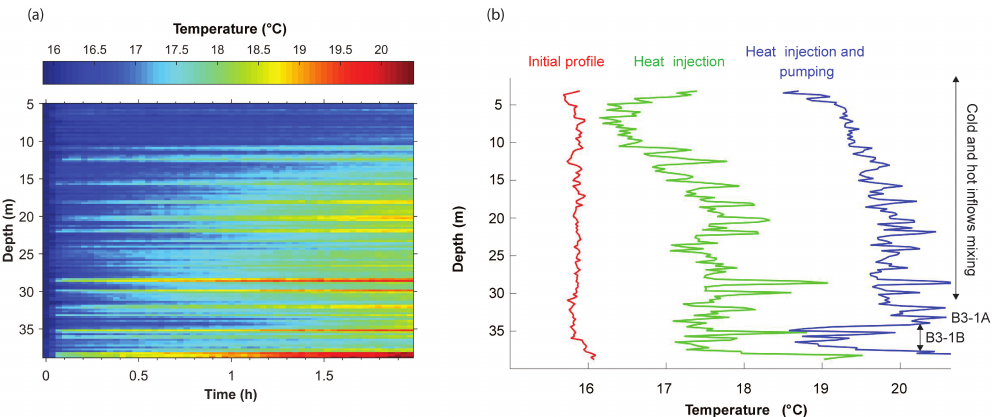
Figure 5. ( a ) Evolution of the temperature measured by FO-DTS in the borehole during Experiment IV and ( b ) di ff erent temperature profiles measured by FO-DTS in the borehole after 1 h 30 min of heat injection during Experiment IV (green) and during Experiment III (blue), compared to the initial profile